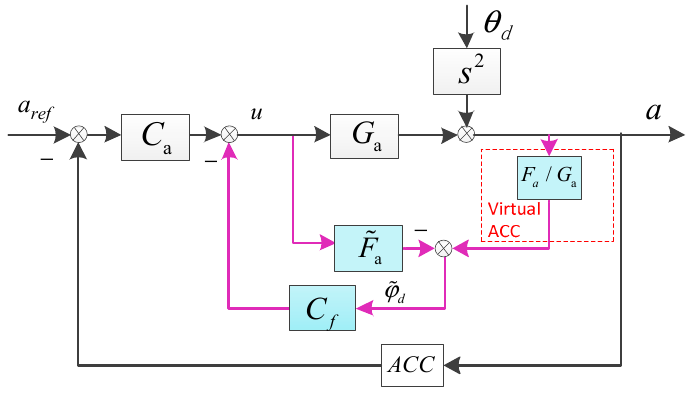
Figure 3. The FDOB method.